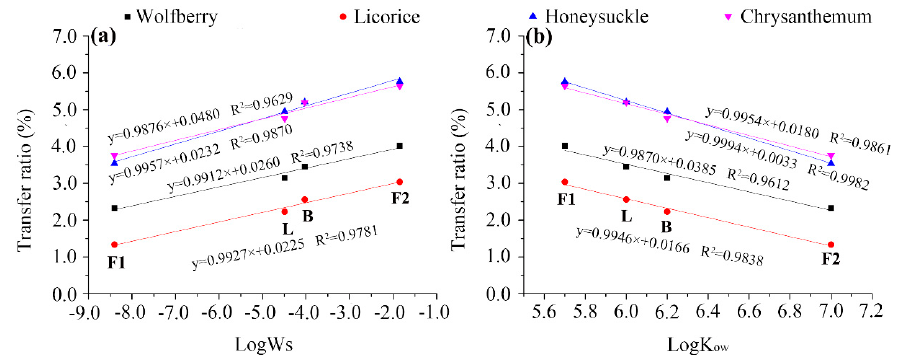
Figure 4. Effect of tea/water ratio on the transfer ratios of the four pyrethroid residues from wolfberry ( a ); licorice ( b ); honeysuckle ( c ); and chrysanthemum ( d ) tea to infusions. Different minor case letters (a, b) at the top of the columns mean significant differences of transfer ratio at a p value of 0.05.